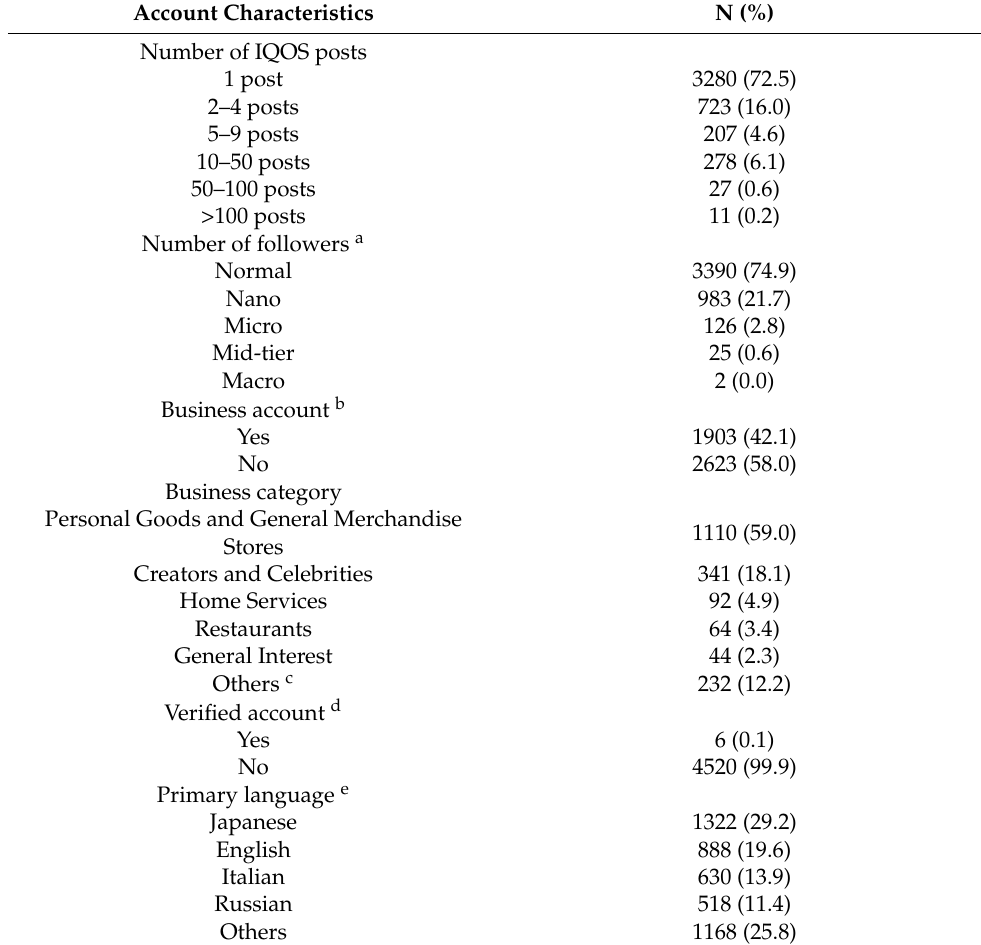
Table 1. Characteristics of Instagram accounts with IQOS posts (N =